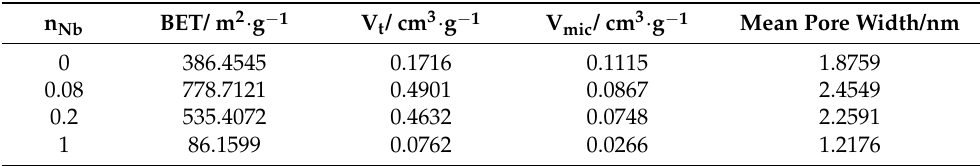
Table 2. Pore structure parameters of Nb/SiO 2 materials with various n Nb calcined at 400 ◦